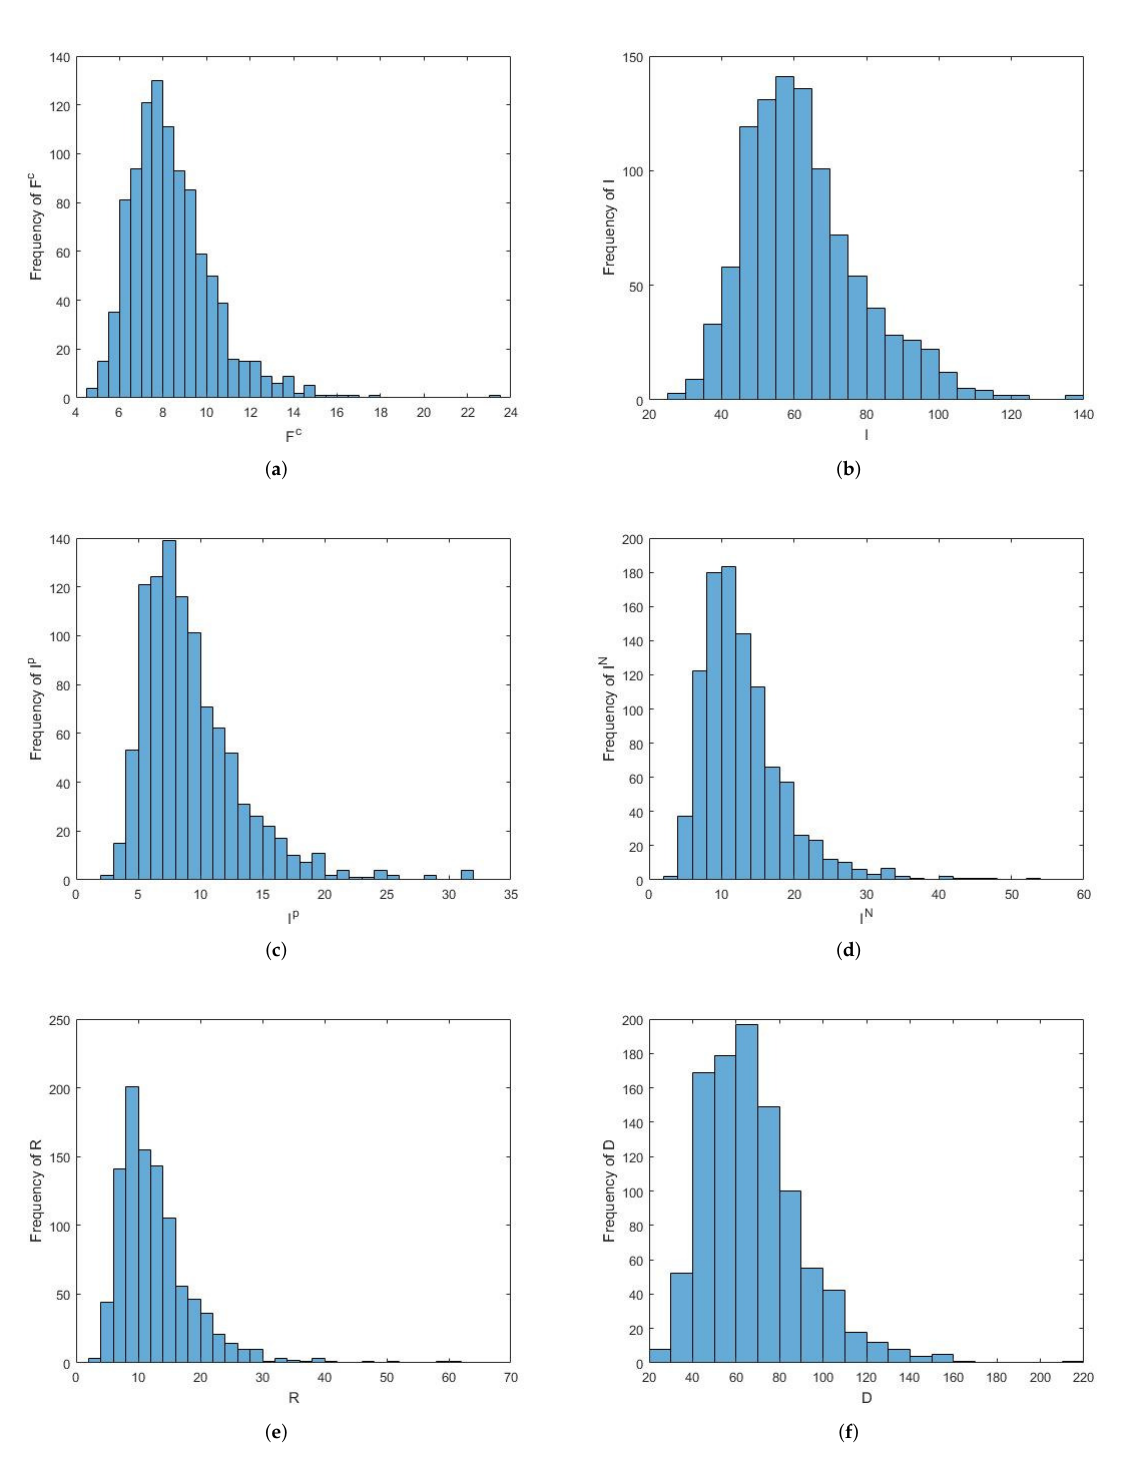
Figure 3. The probability distribution histogram of ( F c ( t ) , I ( t ) , I P ( t ) , I N ( t ) , R ( t ) , D ( t )) for the stochastic model (1). ( a ) F C ( t ) : researchers using fractional differential operators with non-singular kernels. ( b ) I ( t ) : researchers that have been affected by the harmful papers. ( c ) I P ( t ) : researchers that have been affected, but still have positive opinions about non-singular kernel derivatives. ( d ) I N ( t ) : researchers that have been affected and have negative opinions about non-singular kernel derivatives. ( e ) R ( t ) : researchers that have overcome divisive criticism. ( f ) D ( t ) : researchers that die, or